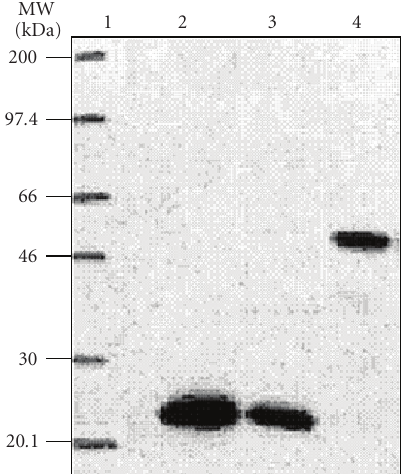
Figure 3: Western blot analysis of the A-domain secretion in S. lividans 1326/pMS115. Supernatant of the S. lividans 1326/pMS115 strain grown on NMMP medium was concentrated 50x, lyophilized, resuspended in PBS, then dialyzed as described in “Materials and Methods.” Proteins were run on a 15% SDS polyacrylamide gel. Lane 1: molecular weight standards (MW) from Amersham;